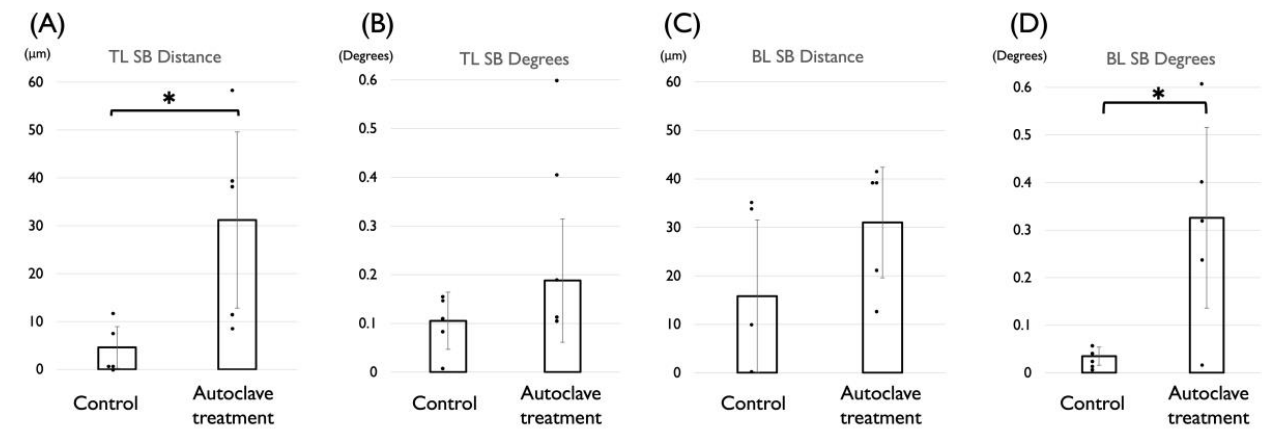
Figure 3. The effect of autoclave treatment on the distance and angle between the scanbodies. Student’s t –test, *: p < 0.05. ( A ) Distance of TL SB. ( B ) Angle (in degrees) of TL SB. ( C ) Distance of BL SB. ( D ) Angle (in degrees) of BL SB.